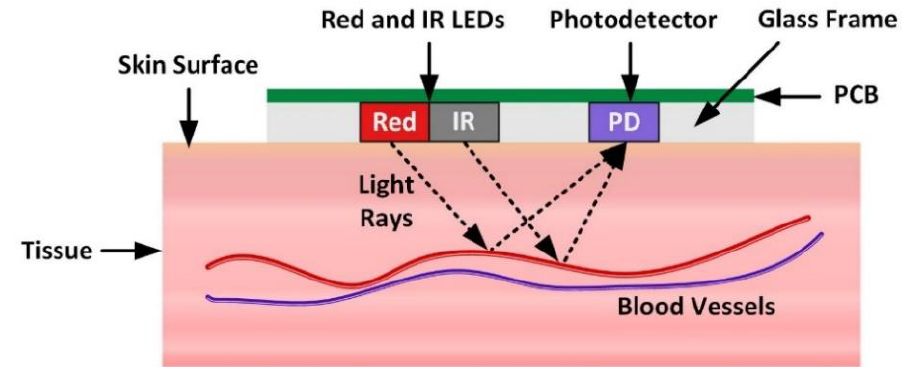
Figure 5. Working principle of a reflection-type PPG